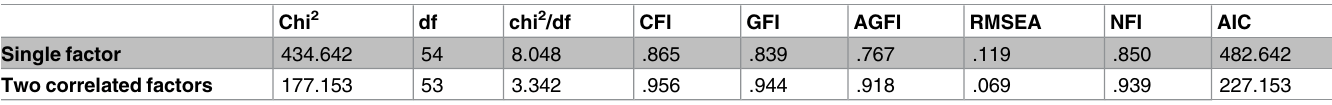
Table 1. Goodness of fit statistics for tests of factorial